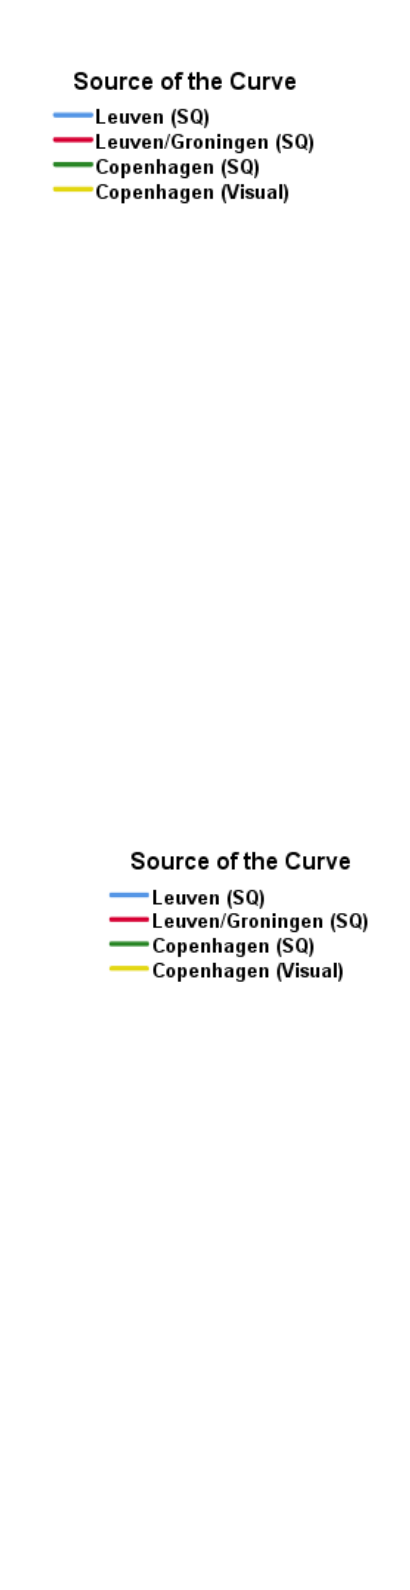
Figure 2. Receiver operating characteristic of four composite scoring systems. ( A ): Glucocorticoid- naïve patients; ( B ): Glucocorticoid-treated patients. SQ = semiquantitative (VOI-based) 3-point scores. Visual = Visual 3-point scores. AUC: Leuven (SQ) 0.93. Leuven/Groningen (SQ) 0.94. Copenhagen (SQ) 0.94. Copenhagen (Visual)